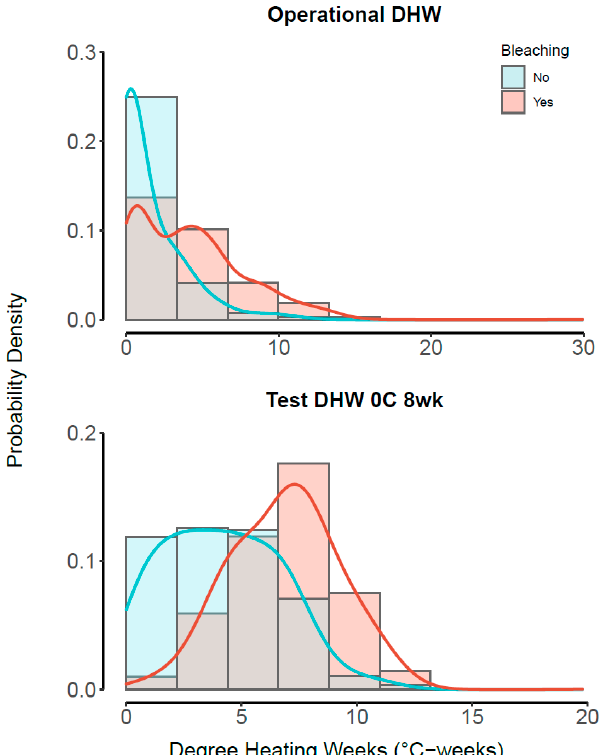
Figure 6. DHW distributions for bleaching records (red) and non-bleaching records (blue), shown as histograms and probability density curves. For comparison of different DHW metrics, the oper- ational metric used by NOAA (DHW op ) is shown alongside one of the best-performing metrics (DHW test-0C-8wk ), calculated using a lower HotSpot threshold (MMM + 0 °C) and a smaller accumula- tion window (8 weeks).